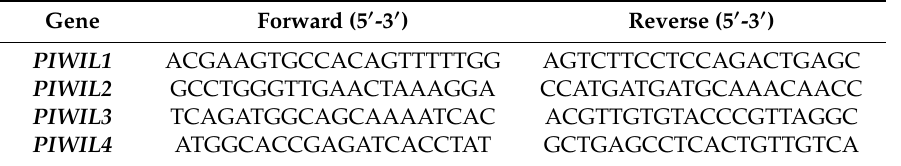
Table 1. Real-time qRT-PCR